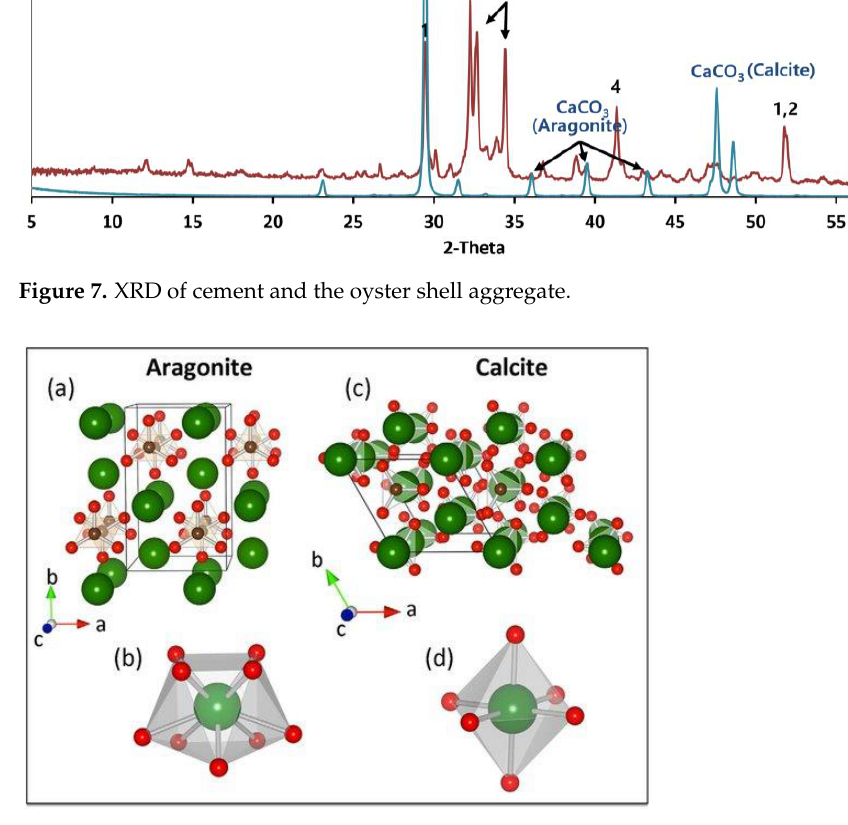
Figure 8. Structures of aragonite and calcite: ( a ) Aragonite; ( b ) Aragonite has a crystal structure; ( c ) In contrast, the crystal structure of calcite; ( d ) Calcium is octahedrally coordinated by O with site symmetry 32.